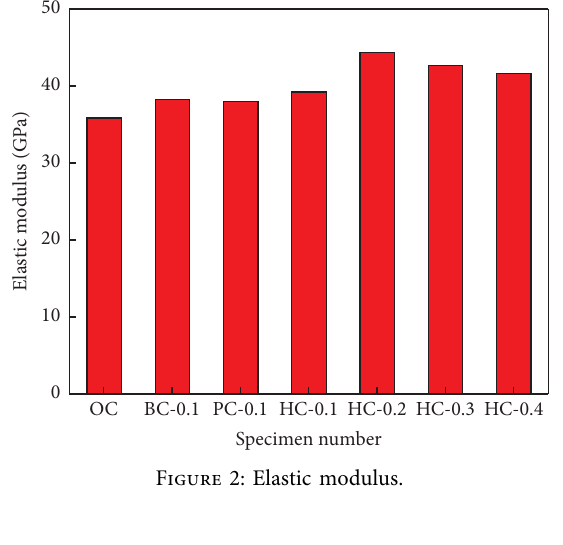
Figure 2: Elastic modulus.